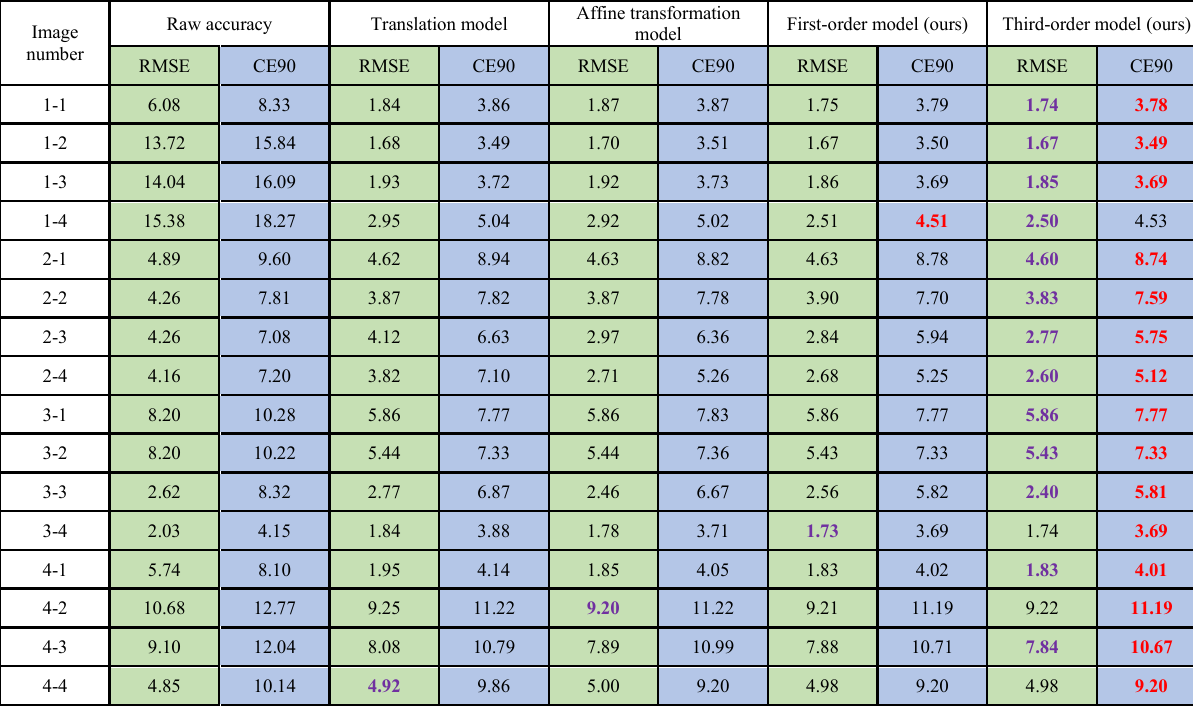
each image to evaluate the effectiveness of the bias model. The experimental results are shown in Table 1. Table 1 uses two indexes, RMSE and CE90, to quantify the positioning accuracy. The values in the green columns are the RMSE errors of each image, the values in the blue columns are the CE90 errors of each image, the purple values are the minimum RMSE values after adjustment, and the red values are the minimum CE90 values after